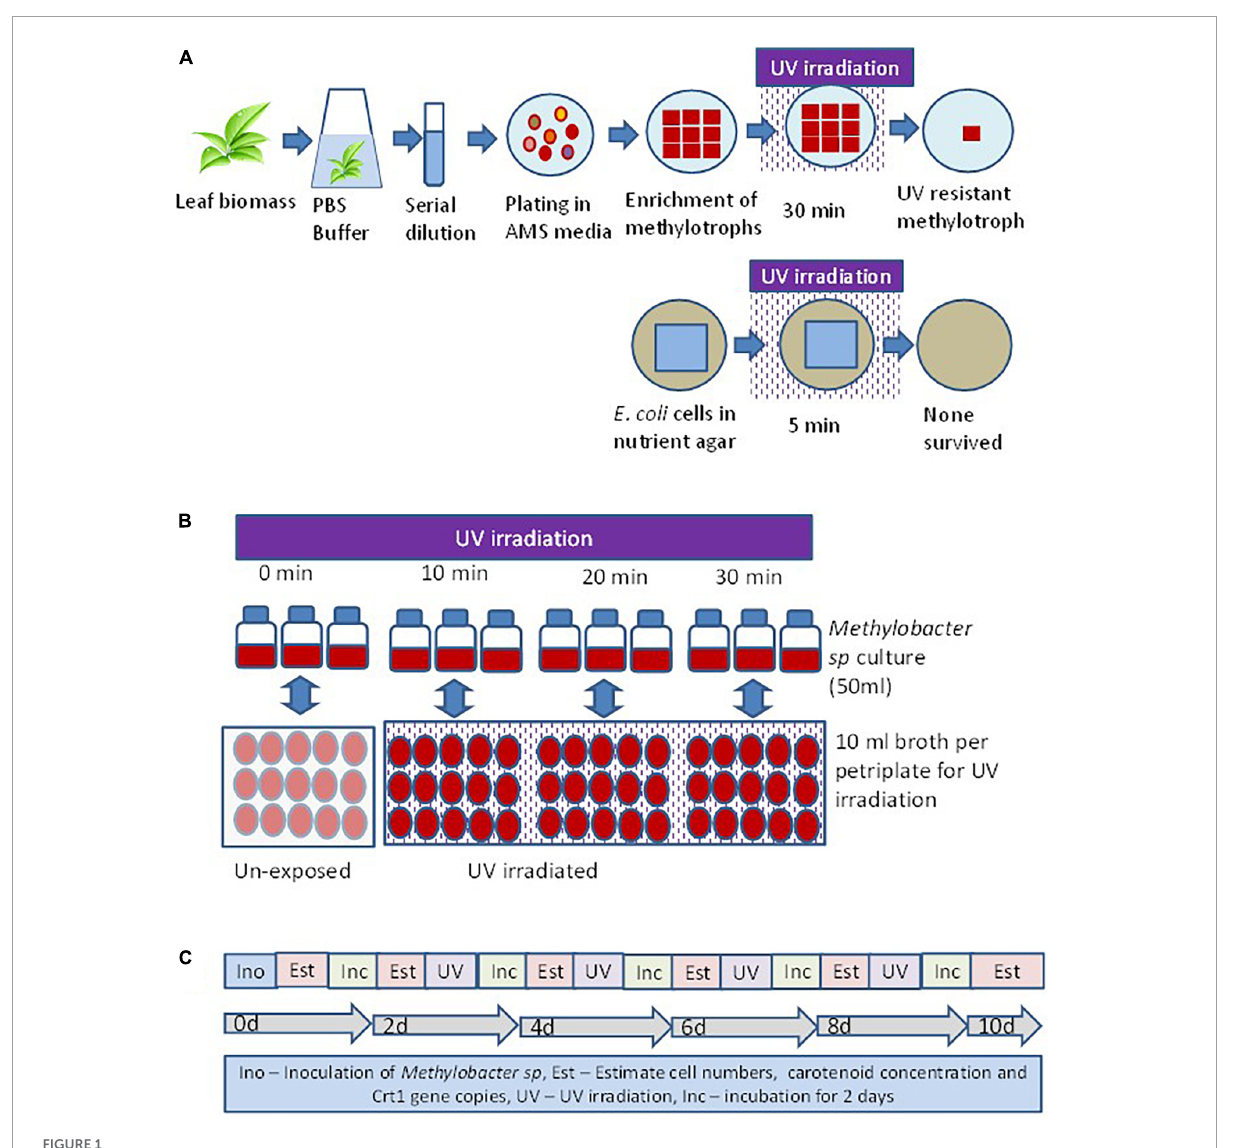
FIGURE1 Experimental set up to evaluate the response of methylotroph to UV irradiation. (A) Isolation of UV-resistant methylotrophs from the phylloplane of plant leaf biomass. Methylotrophs isolated by enriching leaf surface bacteria in ammonium mineral salt (AMS) agar. Colonies were UV irradiated for 15 min, and the most resistant one was selected for further study. The 16S rRNA gene of the isolate was homologous ( > 98%) to Methylobacter sp . (B) Experimental layout for evaluating the effect of UV irradiation on growth of methylotrophs,